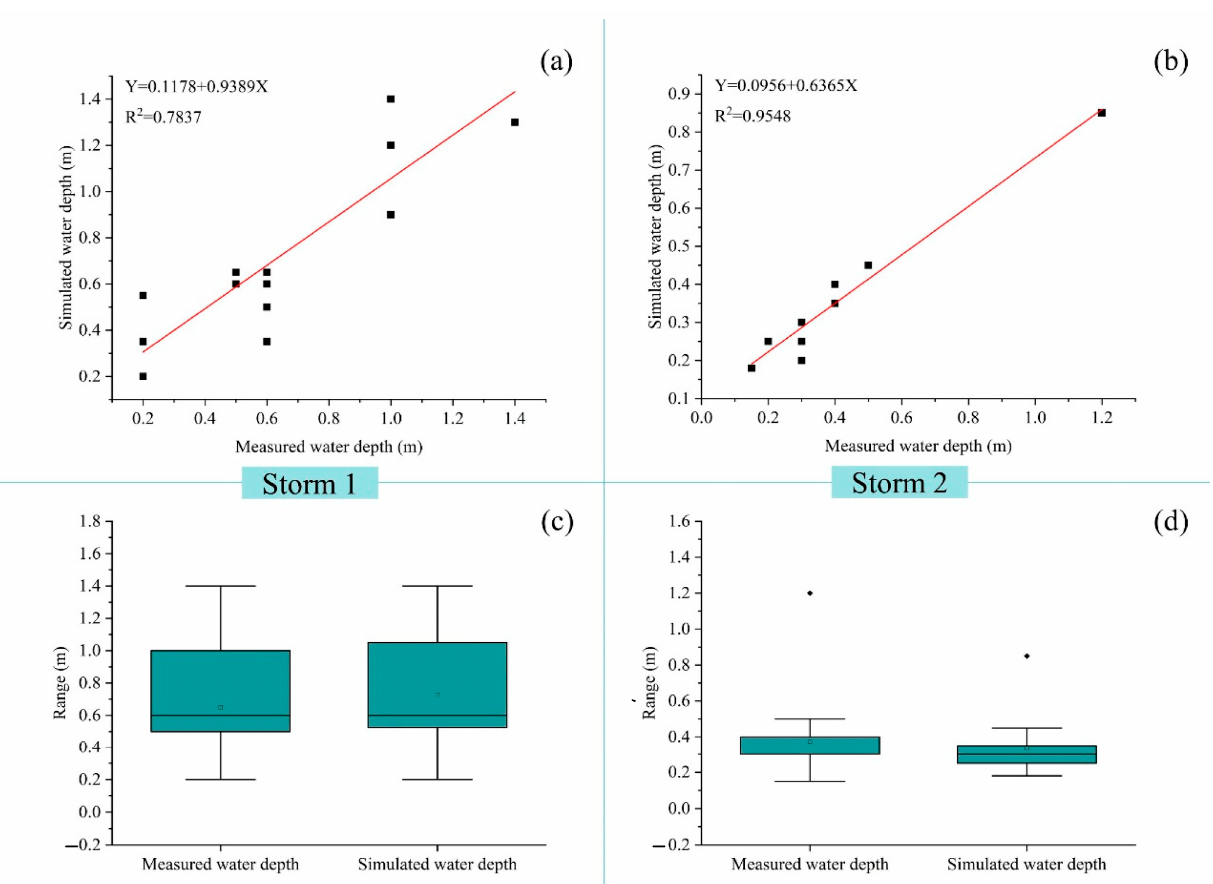
Figure 7. Comparison of simulated water depth and measured water depth of Storm 1 ( a , c ) and Storm 2 ( b , d